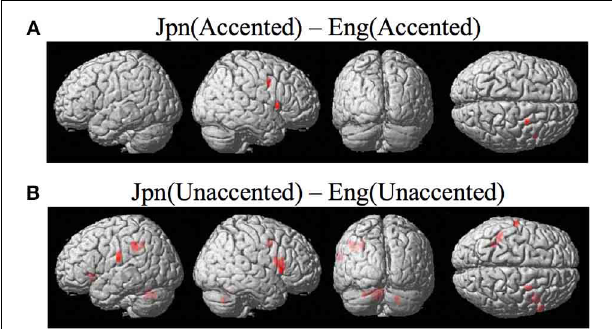
FIGURE 5 | (A) Contrast investigating specific brain regions involved with the perception of foreign-accented productions of a second-language phonetic category, Jpn(accented) – Eng(accented). Activity is present in the right ventral inferior premotor cortex including Broca’s area PMvi/Broca’s right ventral superior premotor cortex PMvs. (B) Activity for perception of foreign-accented productions of a second language phonetic category that may not be specific Jpn(unaccented) – Eng(unaccented) was found in the left and right PMvi/Broca’s, the right PMvs/PMd, the right Broca’s area BA45, the left inferior frontal gyrus BA47, the left postcentral gyrus, the left inferior parietal lobule, and the left and right